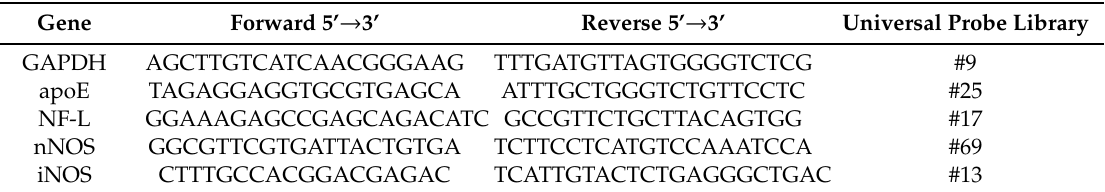
Table 1. Primers used for the quantitative polymerase chain reaction.